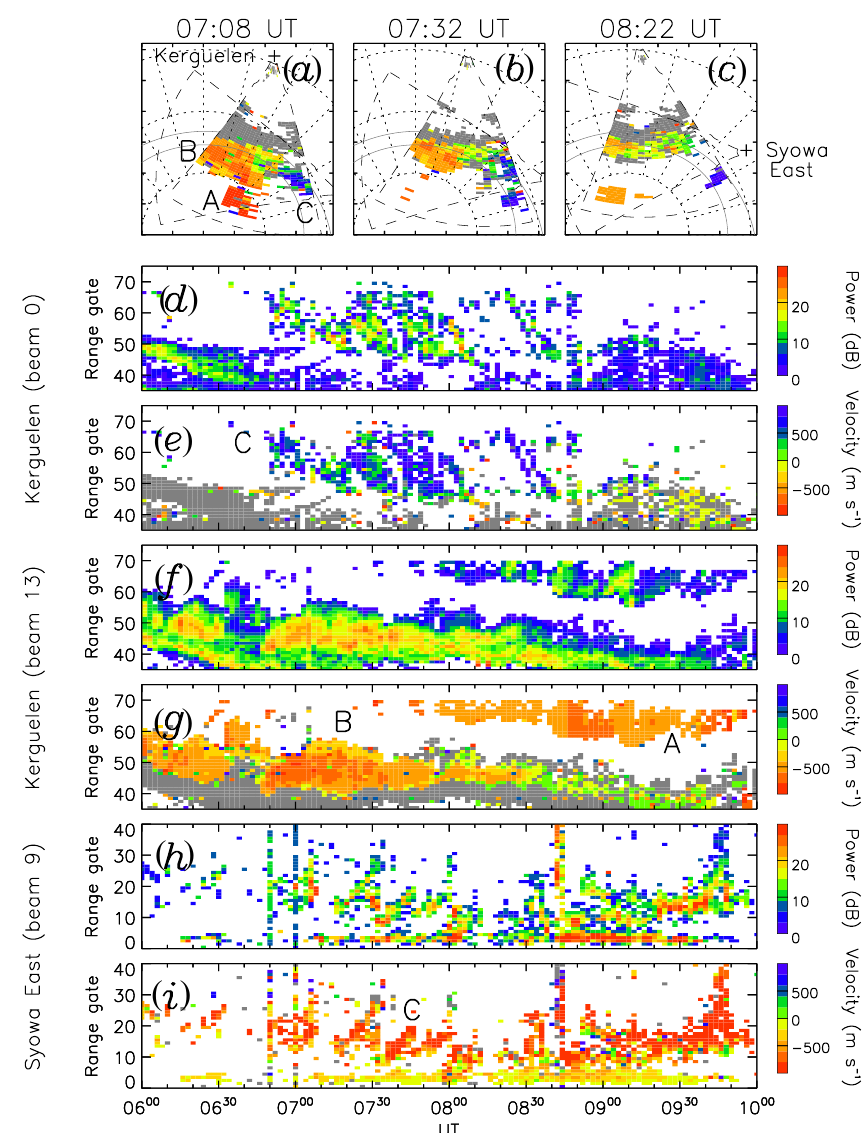
Figure 8. (a–c) Line-of-sight velocities (blue towards the radar, red away from the radar) from the Kerguelen SuperDARN radar in the Southern Hemisphere, at 07:08, 07:32 and 08:22UT. Grey regions are ground scatter. The data are presented in geomagnetic latitude and magnetic local time coordinates, with dotted circles indicating geomagnetic latitudes of 60, 70 and 80 ◦ and dotted lines showing local time meridians with local noon at the top. The outline of the radar field of view is shown by dashed lines, as is the field of view of the Syowa East radar. Grey circles indicated the expected locations of the poleward and equatorward edges of the auroral oval. Three regions of backscatter are indicated by the letters A, B and C. (d–i) Backscatter power and line-of-sight velocity from beams 0 and 13 of the Kerguelen radar and beam 9 of the Syowa East radar. Regions of backscatter are also labelled A to